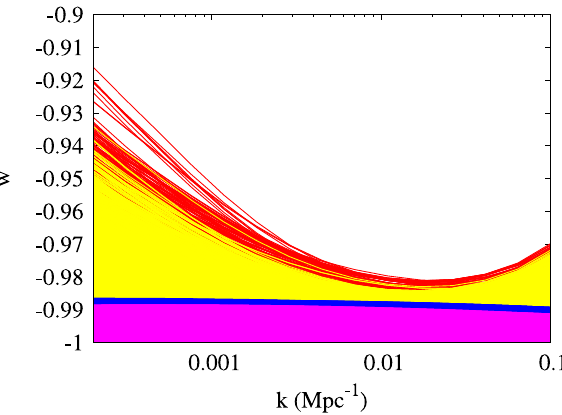
Fig. 1 The evolution of w as a function of the comoving scale k , using only the 5-year WMAP CMB data. Red and yellow are the 95 and 68% confidence regions for the LV formalism. Blue and purple are the same for the flow-equation formalism. From the outside inward, the colored regions are red, yellow, blue, and purple. Image reproduced by permission from Ili´c et al. (2010); copyright by APS 1 + w (cid:3) 0 . 04. Moreover, the spectral tilt itself is also related to the rate of change